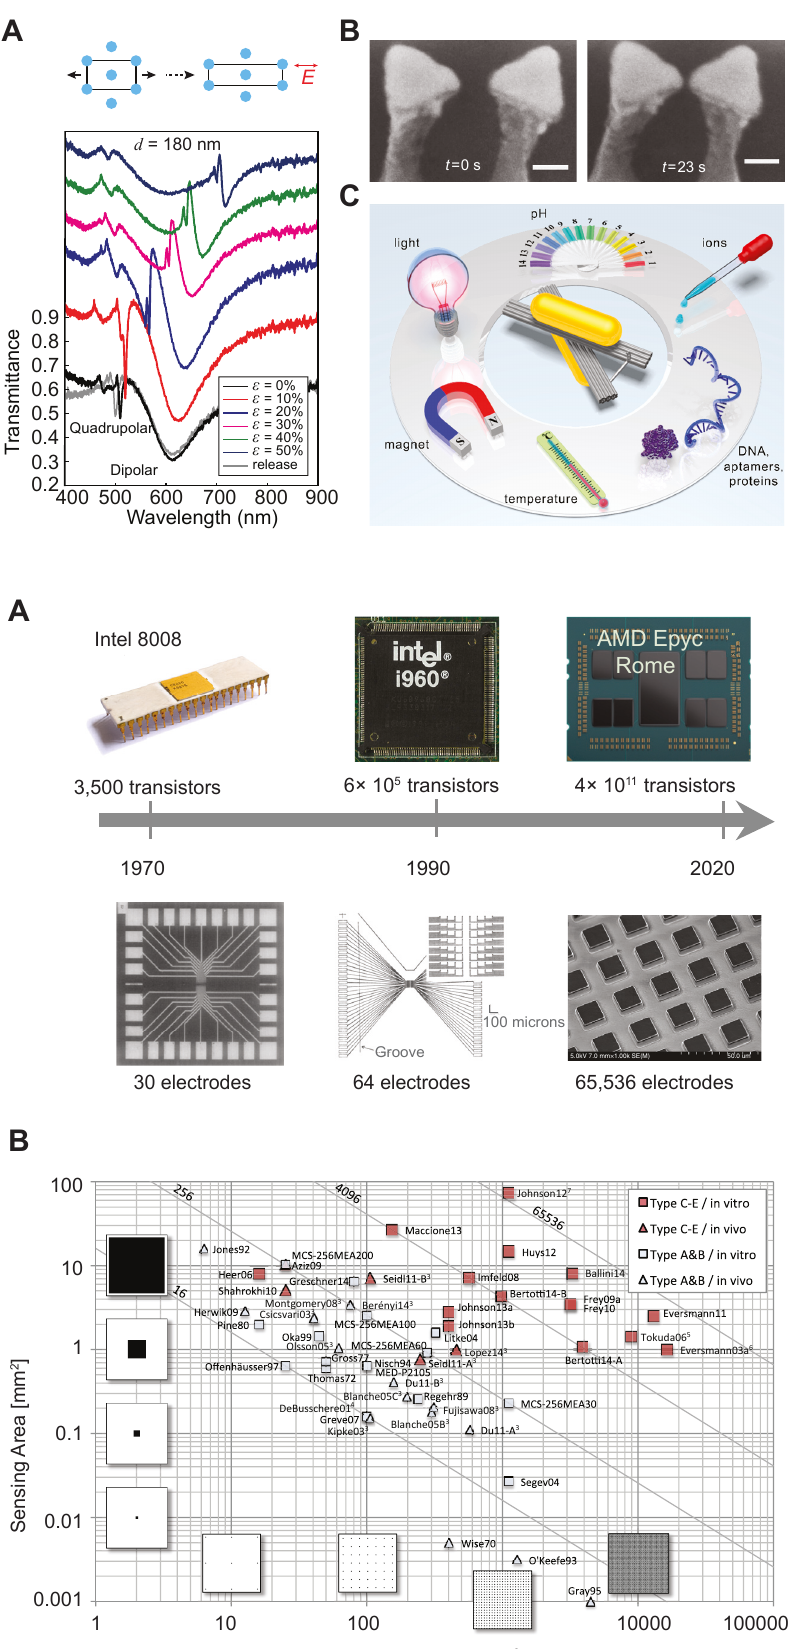
Figure 11: Scaling of microelectrode arrays (MEAs): (A) A timeline of transistor (top panel) and MEA recording (bottom panel) technologies over thepast five decades.The MEAimagesareadaptedfromthestudiesby Thomas et al. [259], Connolly et al. [260], and Tsai et al. [261]. The CPU images are adapted from the courtesy of ‘ Wikimedia Commons ’ and ‘ AMD ’ ; (B) MEA comparison in terms of electrode density and total sensing area. Adapted from the study by Obien et al.